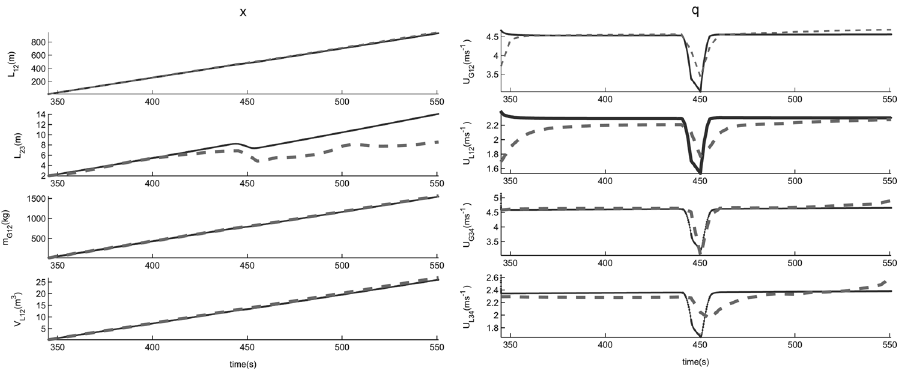
Figure 4. Model verification against OGLA2000: x and q (solid) compared with x est and q est